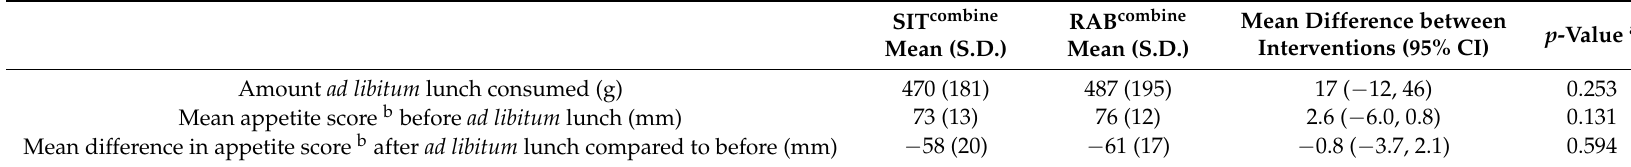
Table 4. Difference in ad libitum lunch consumption and appetite response to ad libitum lunch between regular activity breaks and sedentary interventions ( n =